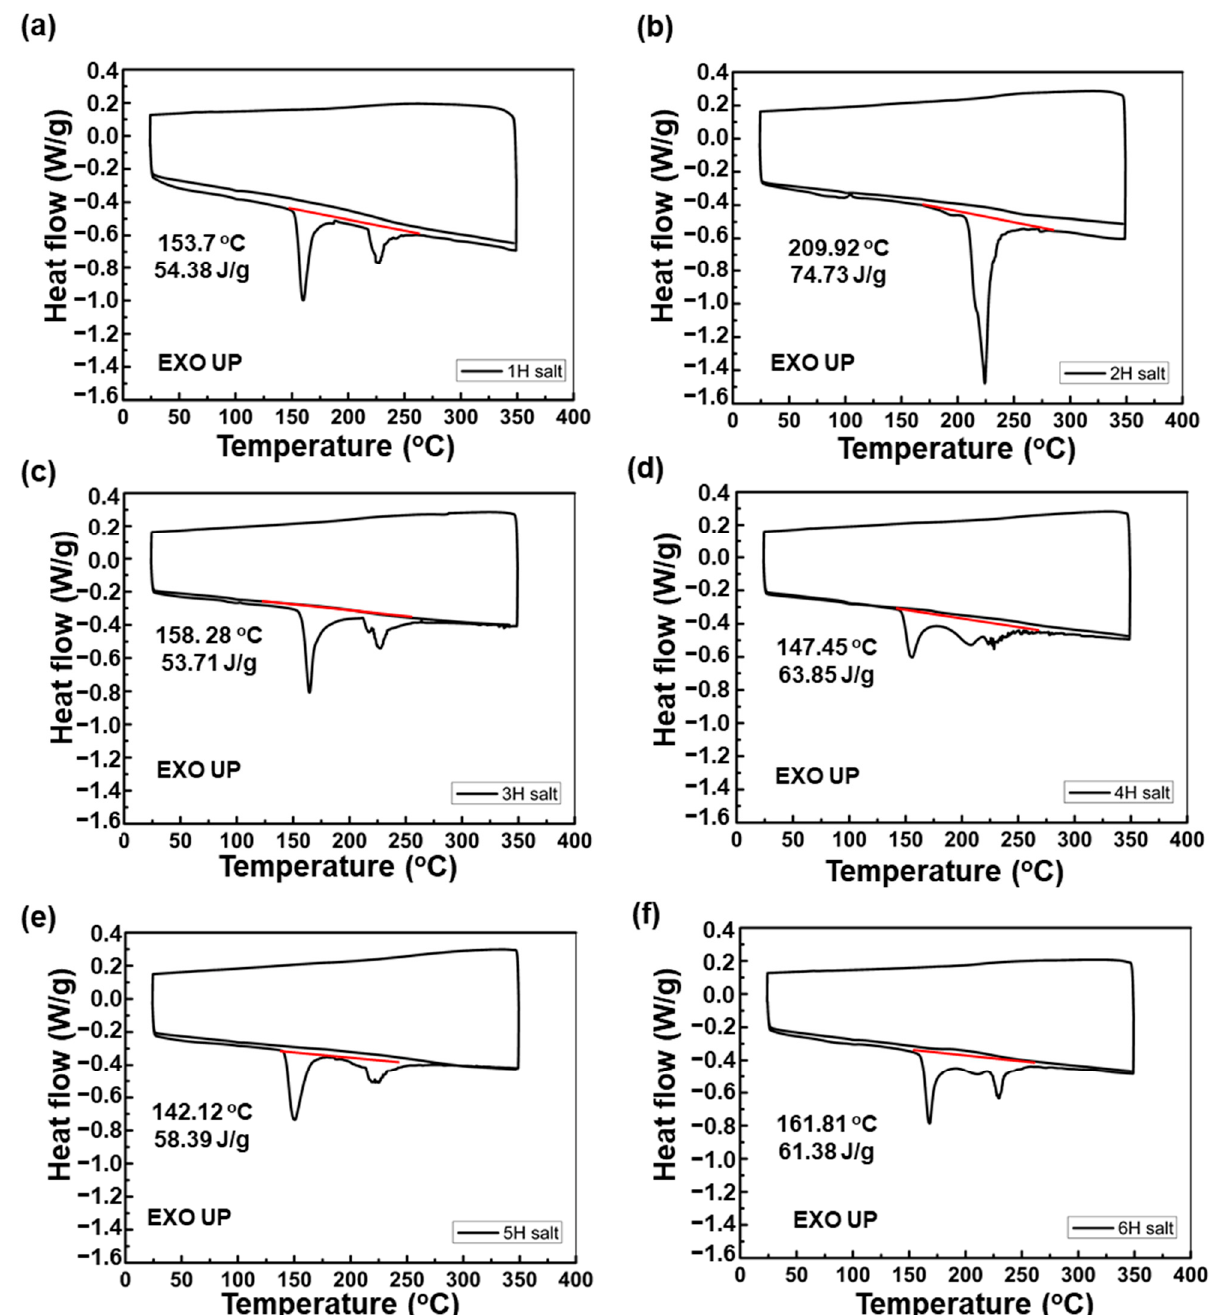
Figure 3. DSC curves of monomer salts which were the intermediate of hydrothermal process, ( a ) monomer salts of 1H, ( b ) monomer salts of 2H, ( c ) monomer salts of 3H, ( d ) monomer salts of 4H, ( e ) monomer salts of 5H, ( f ) monomer salts of 6H.